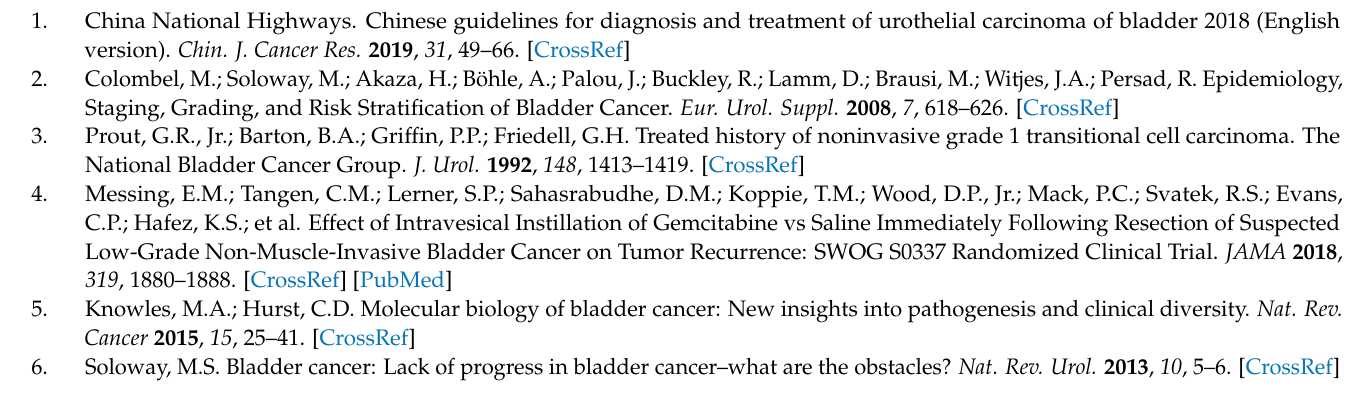
sequences. Figure S1. In the T24 cell line, knockout of STIL inhibited BC tumorigenesis in vitro. Figure S2. In the T24 cell line, STIL played a vital role in the proliferation and cell cycle of BC. Figure S3. In the T24 cell line, SC79 treatment partially reversed the effect of STIL knockout on cell tumorigenesis. Figure S4. STIL and some other genes mRNA expression was significantly upregulated in BBN induced bladder cancer tissues, compared with control samples. The original WB can be found in File